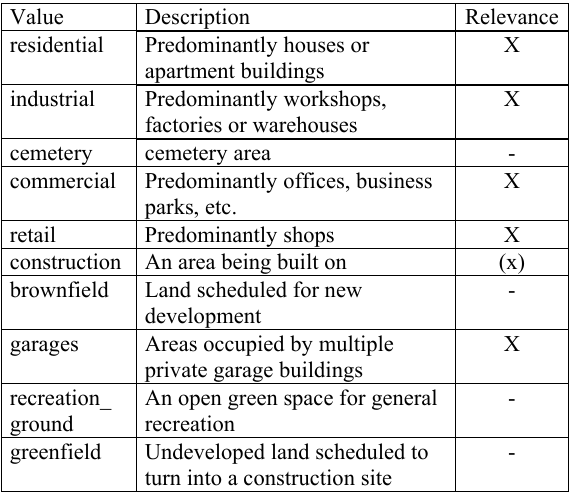
Table 1. The ten most often used values for the “landuse” key that belong to the “built environment” category (entries are ordered by usage starting with the most often used value)